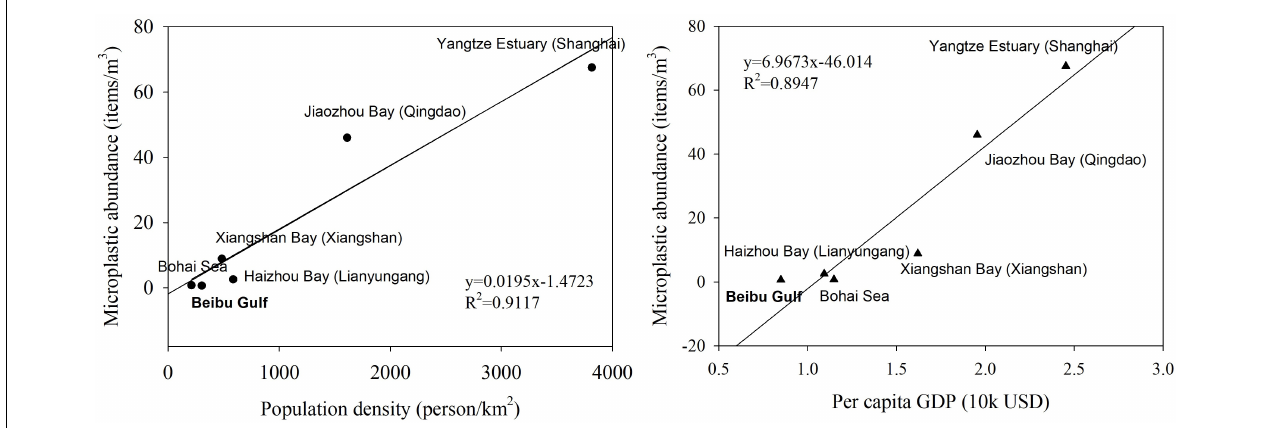
FIGURE 7 | Correlation between microplastic abundance in seawater and population density and per capita gross domestic product. Comparable data were selected from Bohai Sea, Jiaozhou Bay, Haizhou, Bay, Yangtze Estuary, Xiangshan Bay, and Beibu